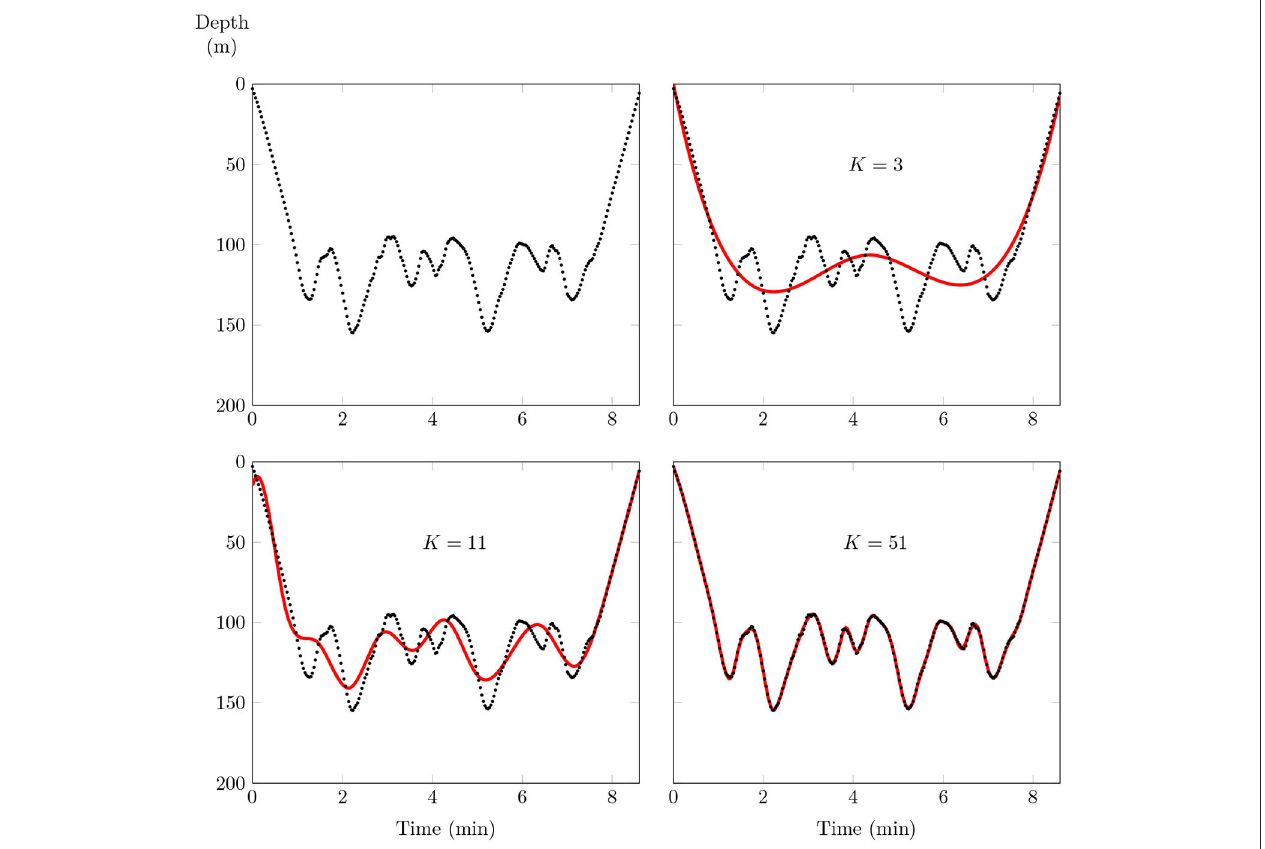
FIGURE 4 | An example of data fitting using a B-spline basis. The dotted line is a sample of a dive (259 sampling location), and the red line is the fitting curve. As the number K of basis functions increases, the quality of the fit is